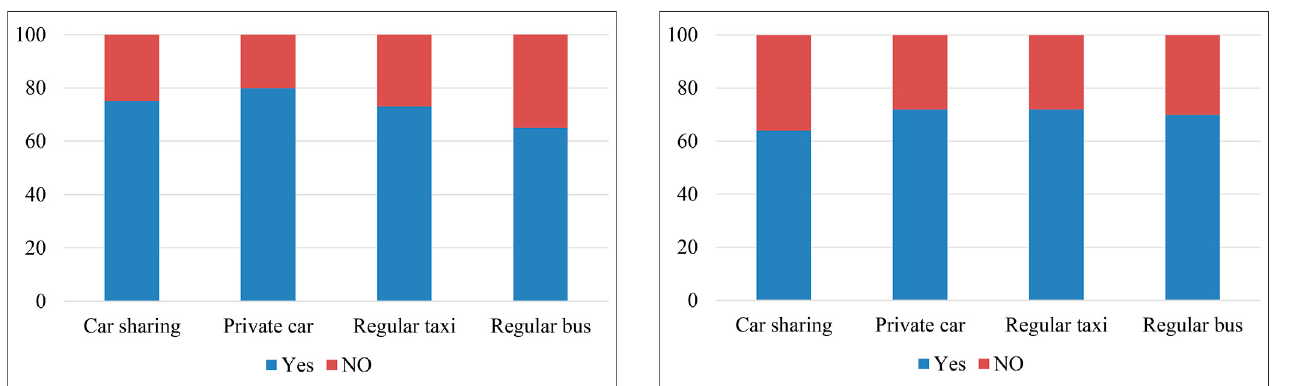
FIGURE 6 | Respondents ’ selection of modes for shopping trips. FIGURE 7 | Respondents ’ selection of modes for recreational